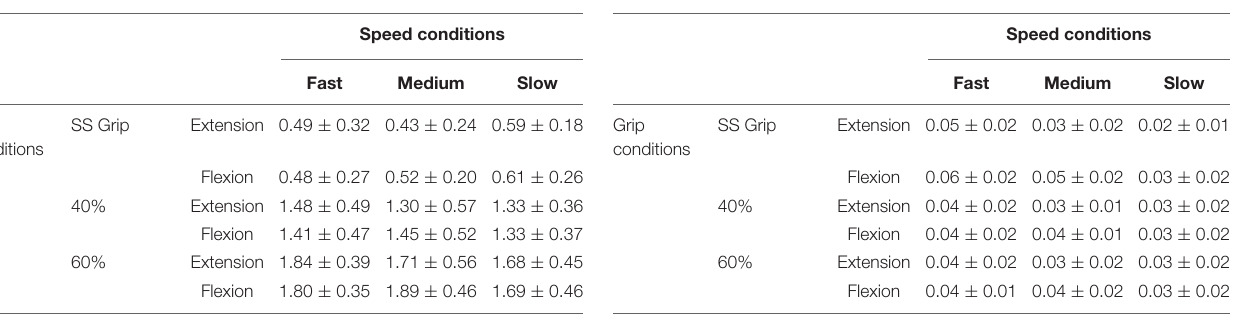
TABLE 5 | Damping parameter B (Nms/rad) for the RH of the healthy population and for the nine experimental